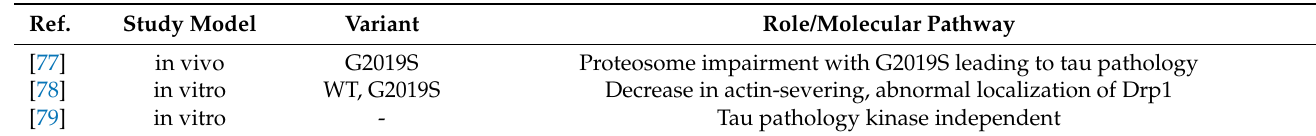
Table 11. Tau neurotoxicity in the context of LRRK2 models.